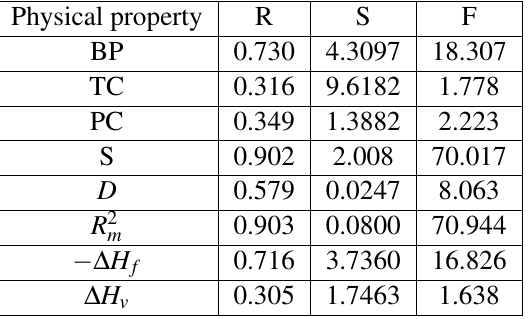
Table 4 Statistical parameters for the linear QSPR model (2).